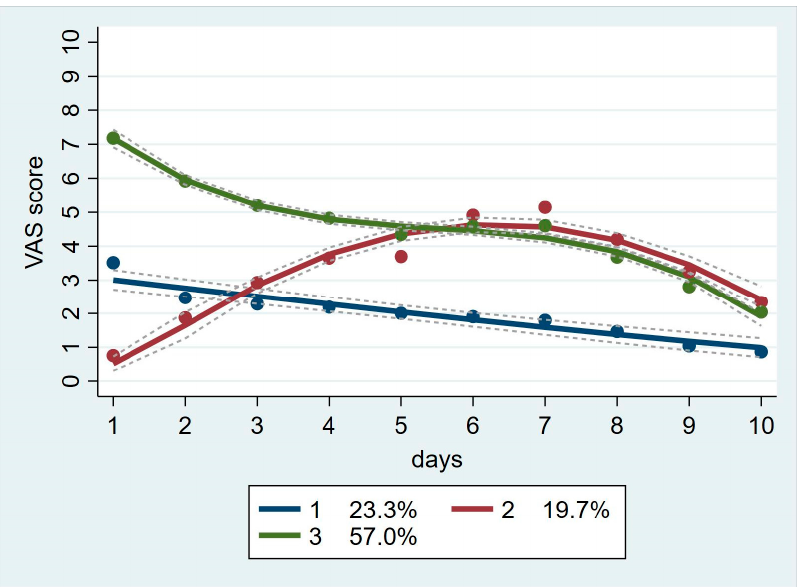
Figure 3. Group-based pain trajectories for the first 10 days after surgery. Pain trajectories for the first 10 days after the operation. 1 is the low group, accounting for 23.3%; 2 is the low-moderate-low group, accounting for 19.7%; and 3 is the high-low group, accounting for 57.0%. VAS indicates visual analog scale.